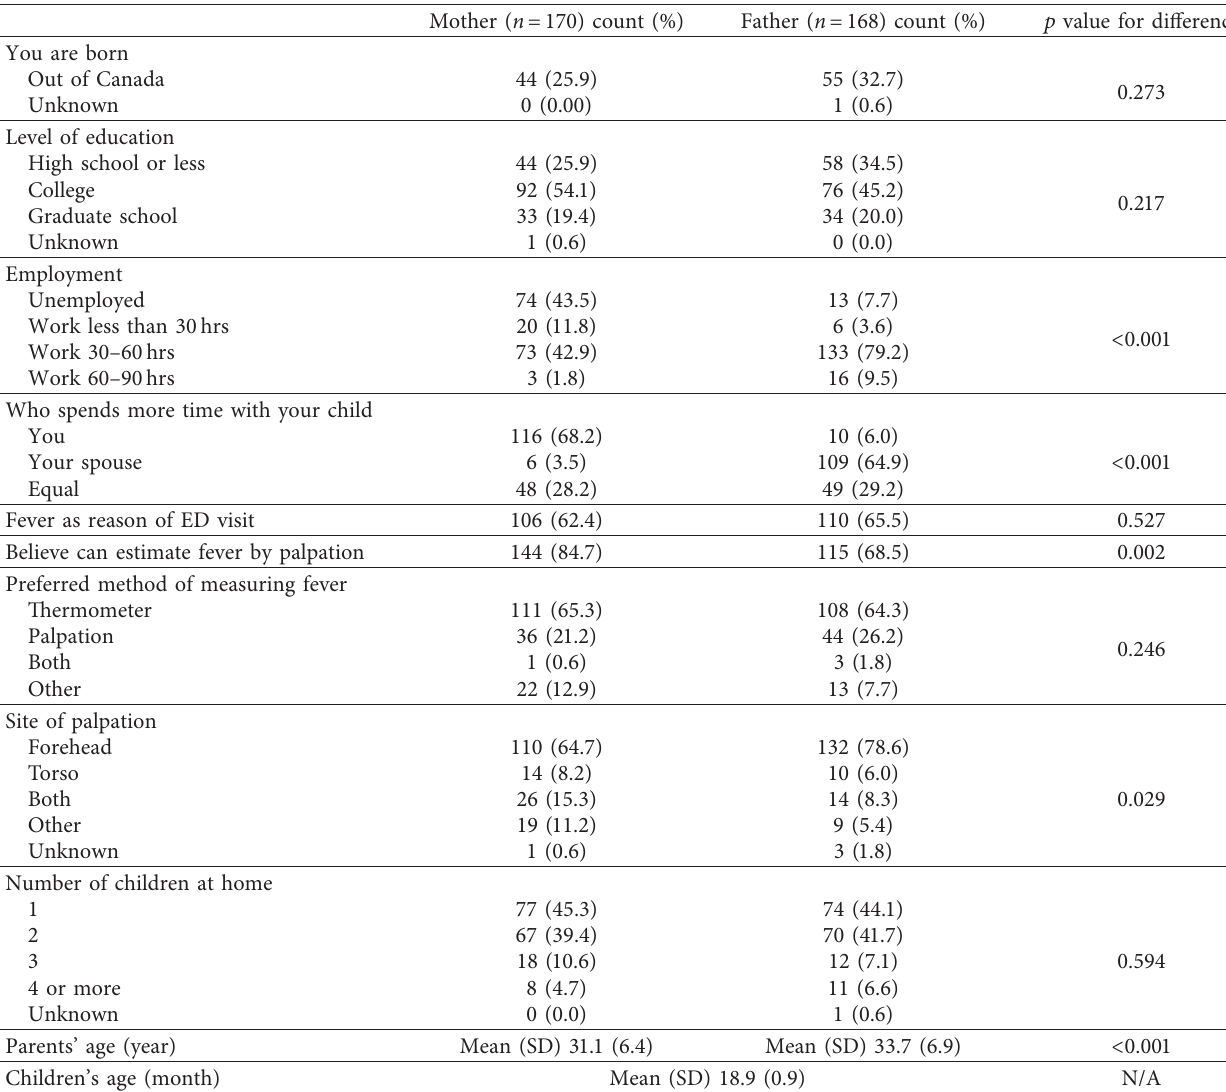
Table 1: Demographic and descriptive characteristics.